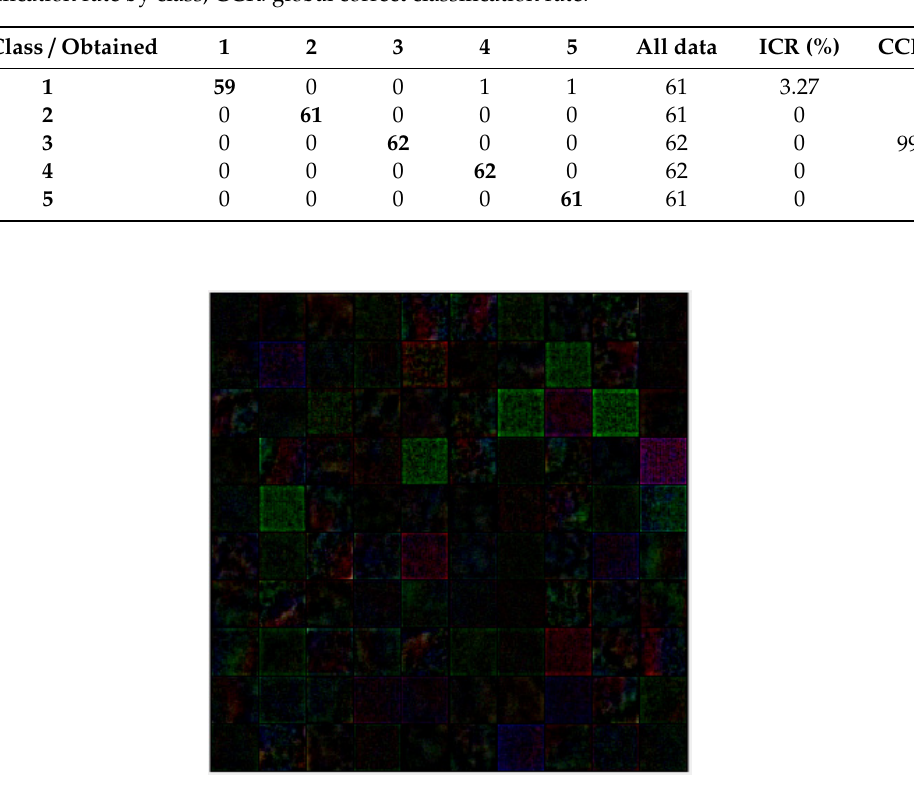
Table 6. Performance criteria related to the confusion matrix using the feature-based approach.